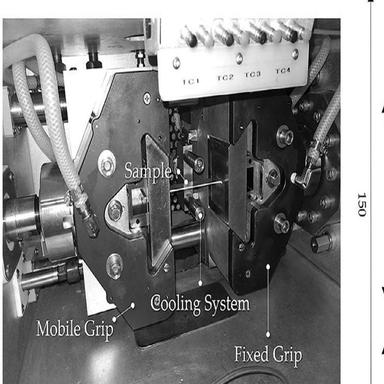
Gleeble 3180 test chamber with the detailed positioning of the 4 thermocouples.